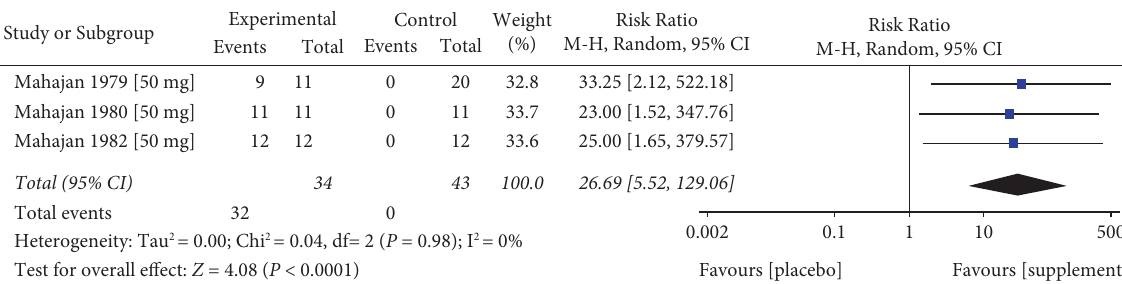
Figure 3: Meta-analysis of the efect of zinc replacement for taste disorder in patients with chronic renal failure. Forest plot including data analysis of three studies with a total of 77 cases of taste disorder induced by chronic renal failure, enrolled to experimental ( n � 34) and control groups ( n � 43). Data expressed as event “total number of cases that improved after receiving the treatment or placebo” and total “total number of participants in either control or experimental group” p value for heterogeneity was 0.98. Te pooled results of this meta- analysis indicated that taste disorder improvement occurred signifcantly more frequently in the supplemented group compared to the control group. Overall RR is positive (RR � 26.69, 95% CI � 5.52–129.06), and statistical signifcance was found to be p < 0 .